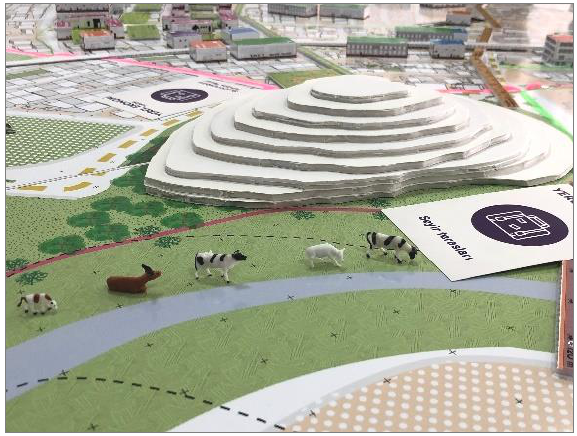
Figure 18 Urban agriculture proposals during